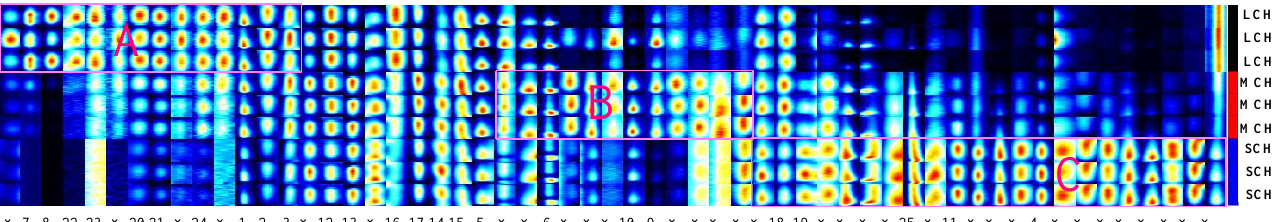
Figure 2. GC-IMS fingerprints of volatile profiles in coconut haustorium. (Each line represented all signal peaks selected from a sample. Each column represented the signal peak of the same volatile substance in different samples. The red boxes with letters A, B and C represented the characteristic substances of LCH, MCH and SCH, respectively. × represented the unidentified substance in the database. The number below the abscissa corresponded to the number of each volatile substance in Table 5). Table 5. Identified volatile compounds in coconut haustorium 1 .